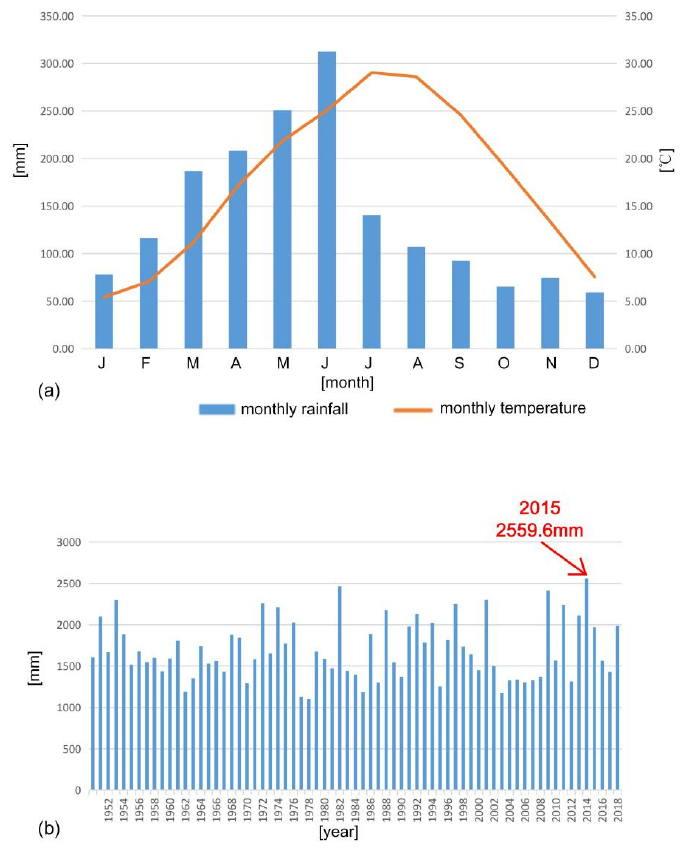
Figure 2. Rainfall and temperature distribution in Quzhou City: ( a ) Climatograph constructed